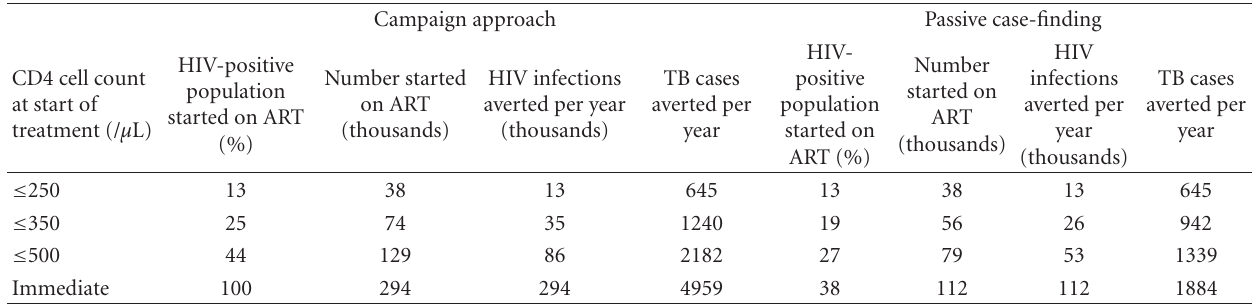
Table 2: Projected prevention impact of campaign approach by CD4 eligibility criteria for Nyanza